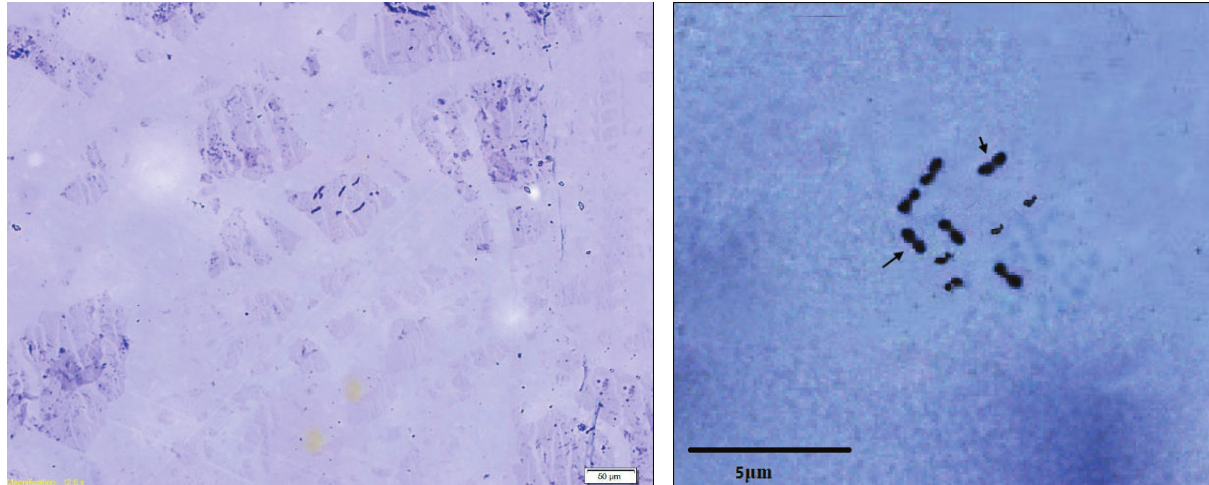
Figure 1. a, b) Mitotic metaphase plate of T. embryophagum . Giemsa staining. Magnification